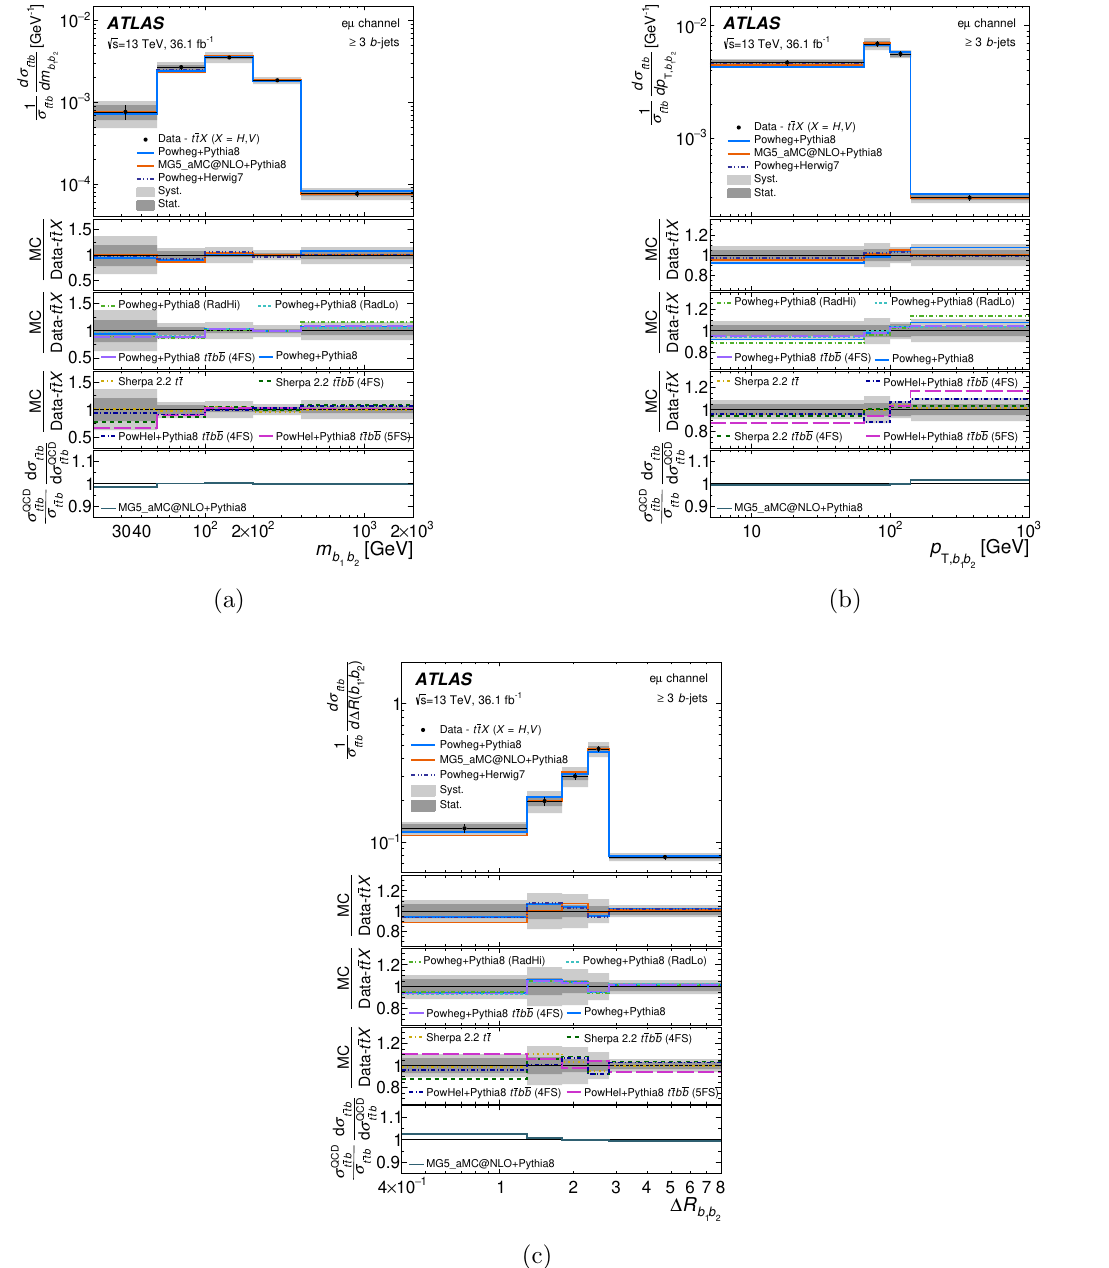
Figure 14. Relative di(cid:11)erential cross-sections as a function of (a) m b (cid:1) R b of two highest- p T b -jets in events with at least three b -jets in the e(cid:22) channel compared 1 ;b 2 with various MC generators. The t (cid:22) tH and t (cid:22) tV contributions are subtracted from data. Four ratio panels are shown, the (cid:12)rst three of which show the ratios of various predictions to data. The last panel shows the ratio of predictions of normalised di(cid:11)erential cross-sections from Mad- Graph5 aMC@NLO+ Pythia 8 including (numerator) and not including (denominator) the con- tributions from t (cid:22) tV and t (cid:22) tH production. Uncertainty bands represent the statistical and total systematic uncertainties as described in section 8. Events with observable values outside the axis range are not included in the